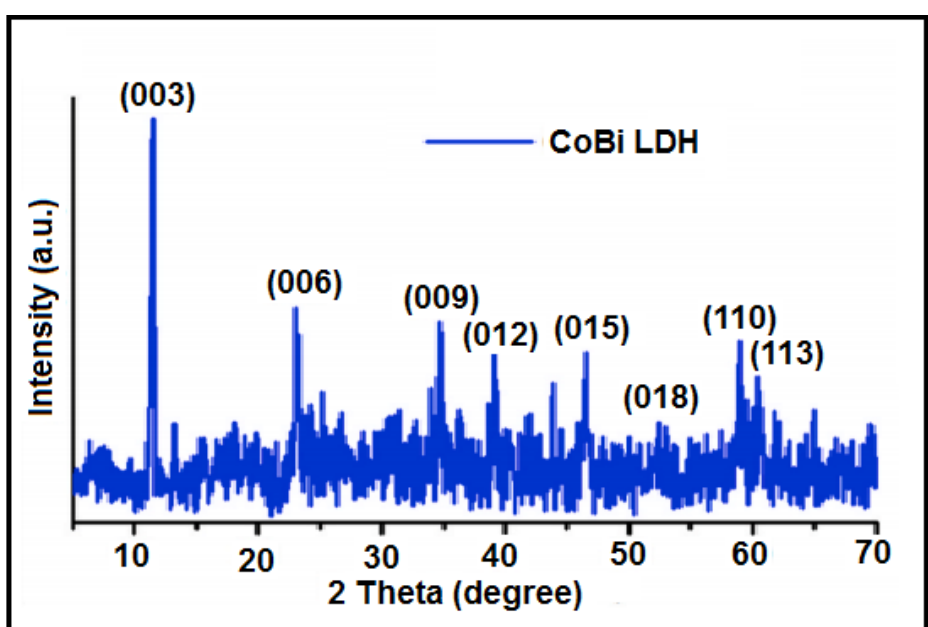
Figure 3. A typical XRD pattern of an LDH-structure; CoBi LDH [1]. Copyright 2021, reproduced with permission from Elsevier.